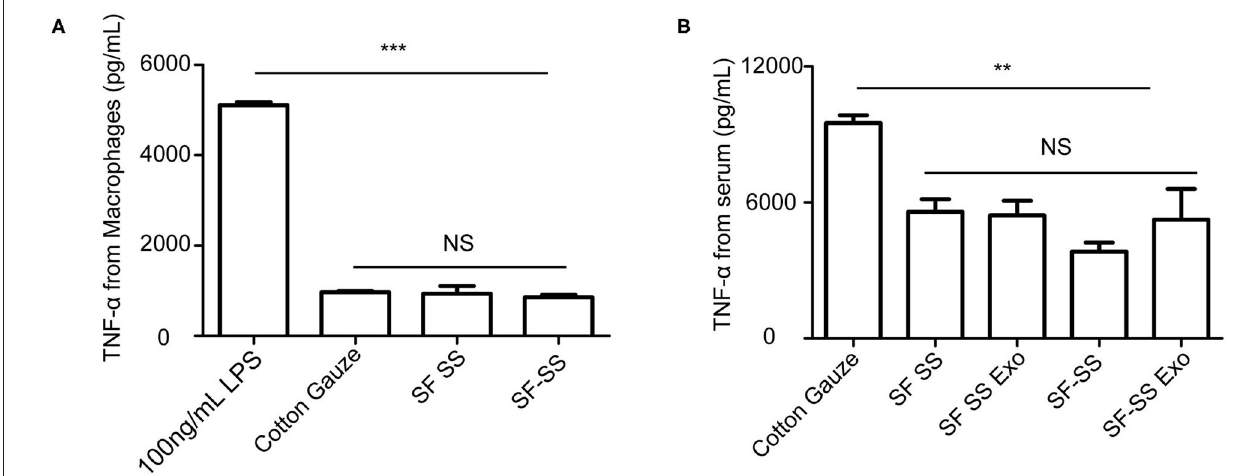
FIGURE 6 | TNF- α released by macrophage or in serum after incubating with SF SS and SF-SS hydrogel sponges. (A) TNF- α release from macrophages after incubating with cotton gauze, SF SS and SF-SS hydrogel. (B) TNF- α in the serum from mice with different treatments. Data is shown as mean ± standard deviation